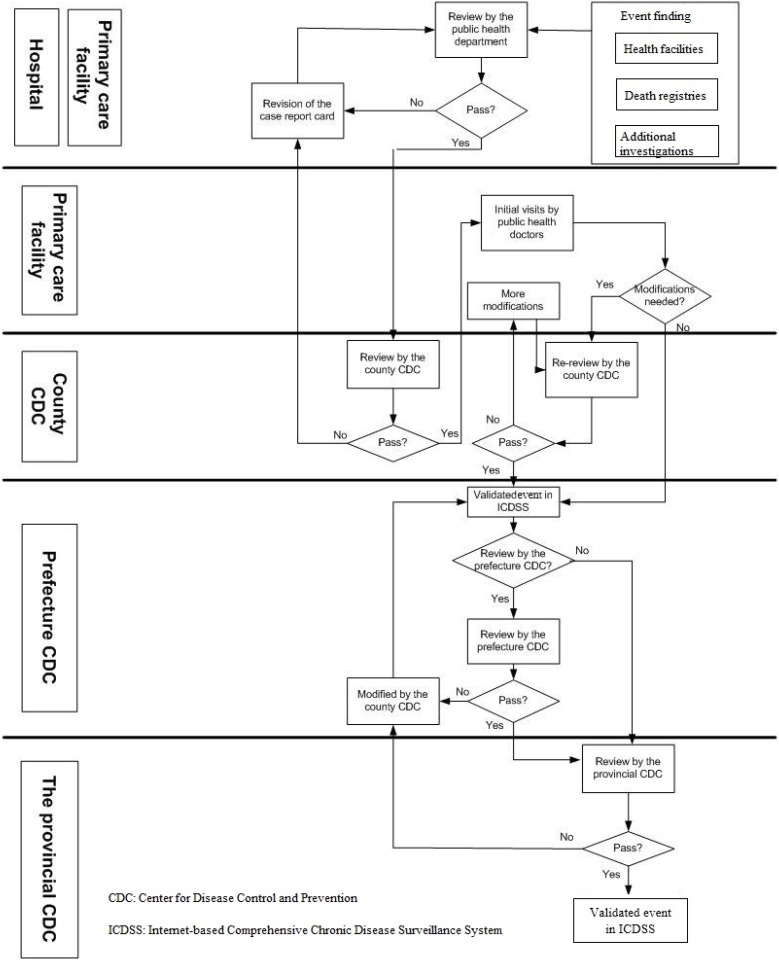
Flowchart of the Internet-based Comprehensive Chronic Disease Surveillance System (ICDSS) in Zhejiang, China.